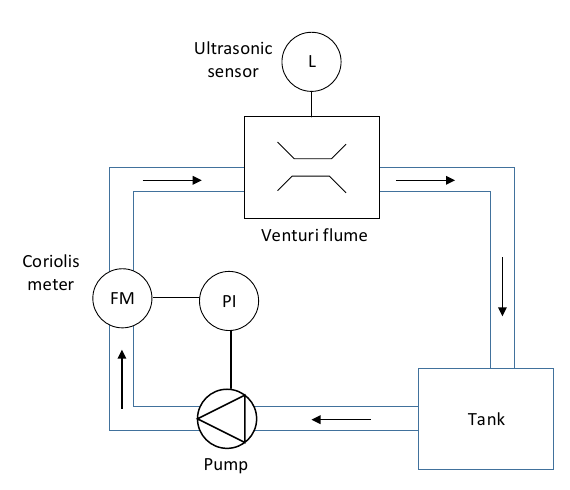
Figure 3: Block diagram of the venturi rig at USN